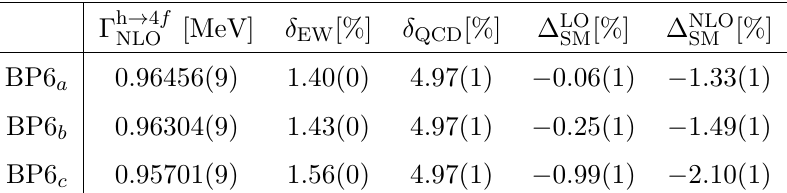
Table 12 . The h 4 f widths in the MS( (cid:21) 3 ) scheme including the EW and QCD corrections of ! the benchmark scenarios BP6 a (cid:0) c (with the numerical errors in parentheses). The last two columns show the deviation from the SM prediction at LO and